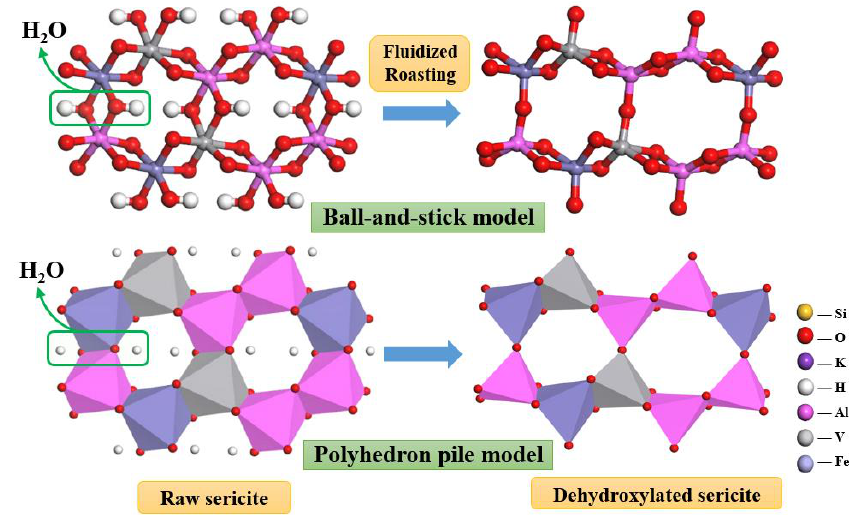
Figure 10. Structural change in sericite O-layer during dehydroxylation.